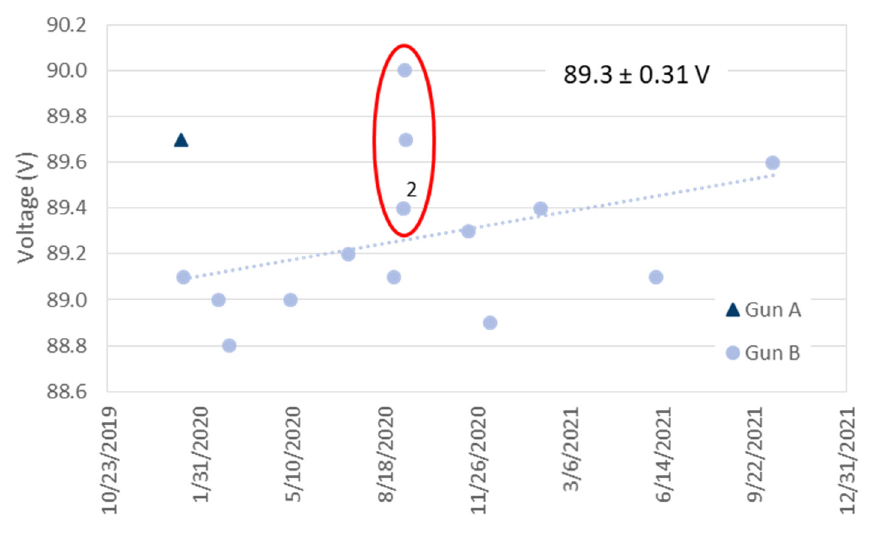
Figure 7. Variability of the torch voltages measured in the period of 2020 and 2021 (‘2’ indicates that one data point is hiding another one).